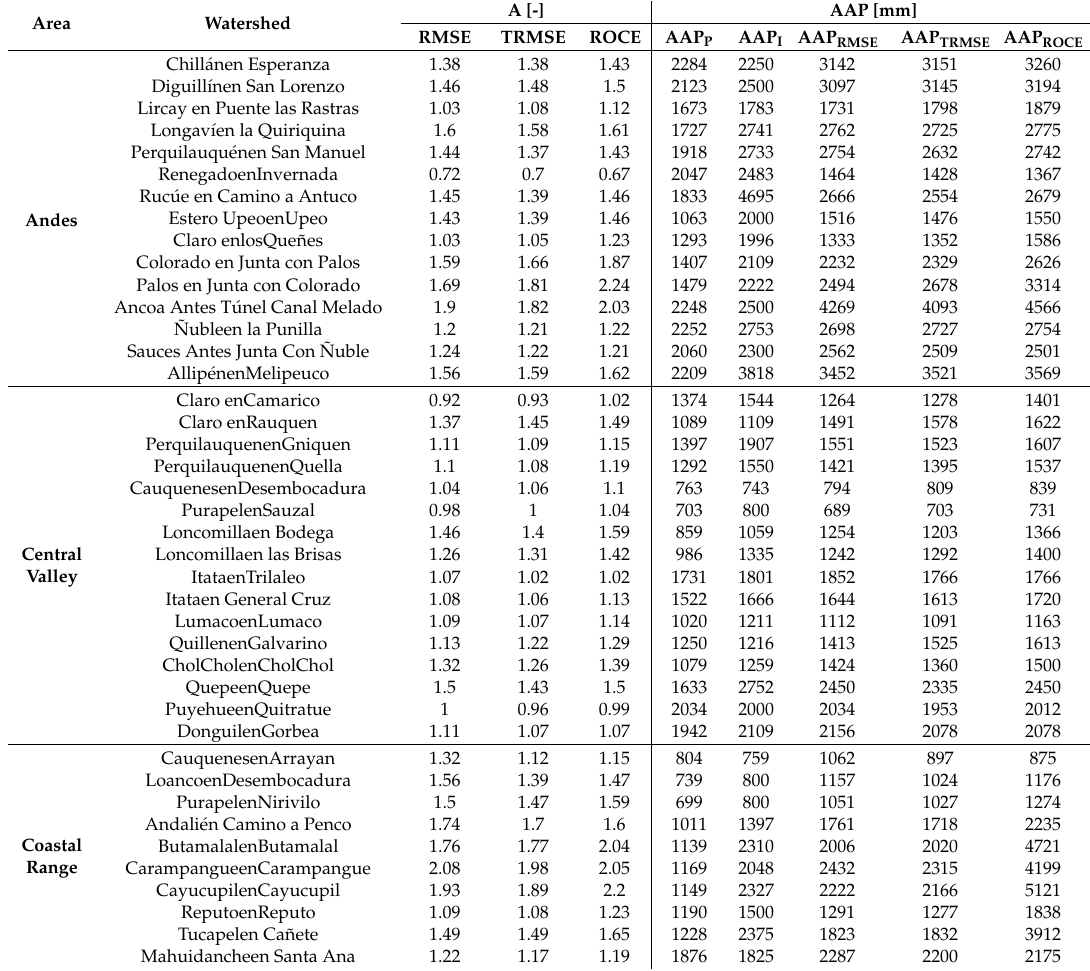
Table 2. Precipitation correction factors estimated by inverse modeling for each watershed, using three objective functions. In addition, the average annual precipitation amounts from National Water Directorate (DGA) precipitation gauge records (AAP P ), isohyets (AAP I ) and inverse modeling (AAP c ) using different objective functions are shown. Made by the